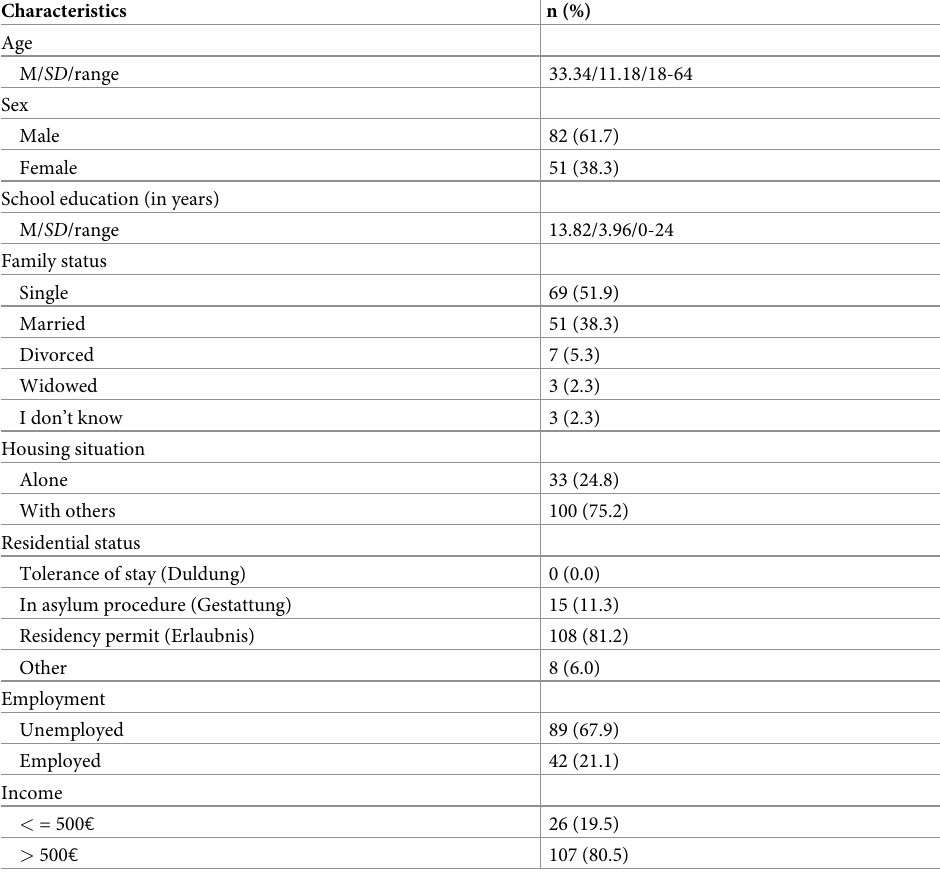
Table 1. Sociodemographic